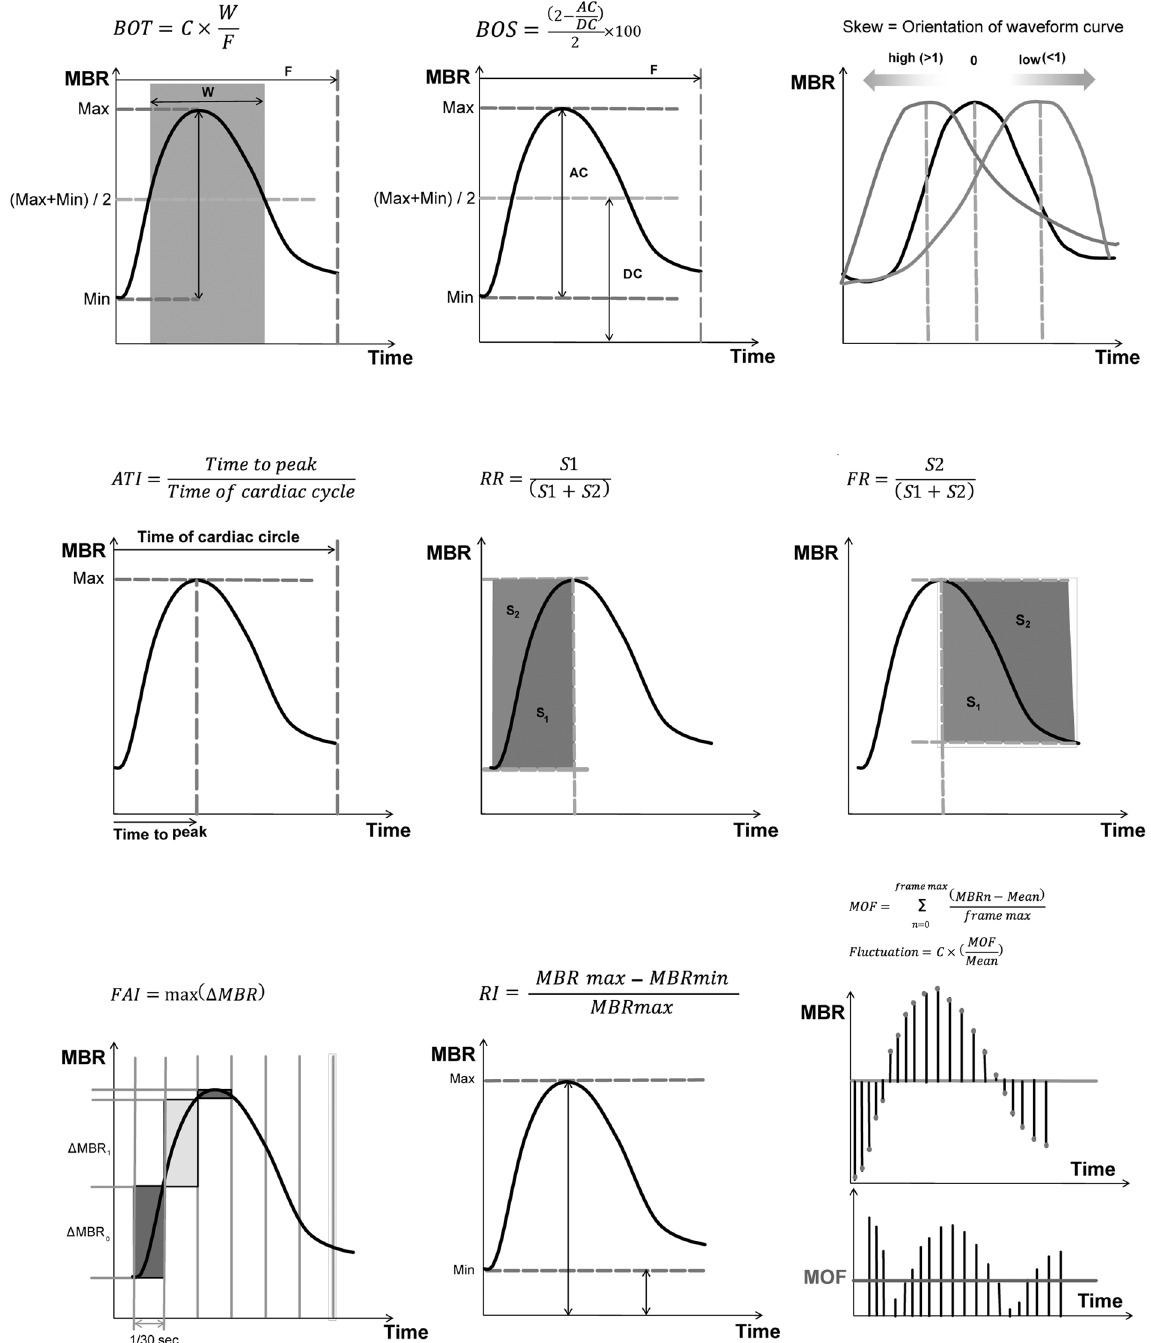
Figure 2. Calculation of the pulse-waveform parameters. Top left: Blow out time (BOT). Top center: blowout score (BOS). Top right: skew. Middle left: acceleration time index (ATI). Middle center: rising rate (RR). Middle right: falling rate (FR). Bottom left: the flow acceleration index (FAI). Bottom center: resistivity index (RI). Bottom right: fluctuation, (MOF) mean of